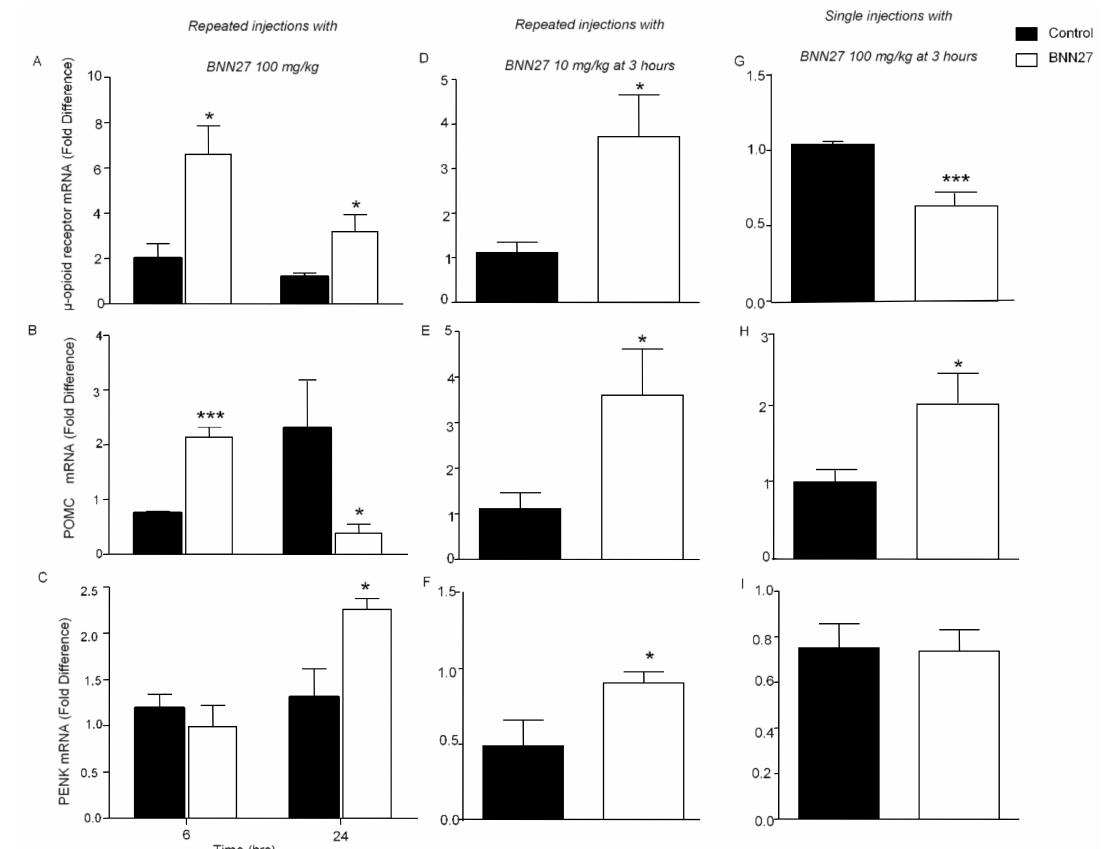
Figure 7. BNN27 induced the expression of opioid peptides and µ -opioid receptor in the inflamed paw. Repeated injections of 100 mg/kg increased the µ -opioid receptor mRNA levels at 6 and 24 h ( A ) as well as POMC mRNA levels at 6 h ( B ) and PENK mRNA levels at 24 h ( C ). Repeated injections of 10 mg/kg increased µ -opioid receptor, POMC and PENK mRNA levels at 3 h ( D – F ). Single treatment at 100 mg/kg decreased the µ -opioid receptor mRNA ( G ) and increased the POMC mRNA levels ( H ). No changes were observed in the PENK mRNA levels ( I ). ( A ) At 6 h, Control n = 3 mice, BNN27-treated group n = 4 mice; at 24 h: Control n = 4 mice, BNN27-treated group n = 4 mice. ( B ) At 6 h, POMC: Control n = 3 mice, BNN27-treated group n = 5 mice; at 24 h: Control n = 5 mice, BNN27-treated group n = 5 mice. ( C ) At 6 h, Control n = 4 mice, BNN27-treated group n = 4 mice; at 24 h: Control group n = 4 mice, BNN27-treated group n = 4 mice. ( D ) Control n = 5 mice, BNN27-treated group n = 5 mice. ( E ) Control n = 5 mice, BNN27-treated group n = 5 mice. ( F ) Control n = 4 mice, BNN27-treated group n = 5 mice. ( G ) Control n = 4 mice, BNN27-treated group n = 5 mice. ( H ) Control n = 4 mice, BNN27-treated group n = 5 mice. ( I ) Control n = 4 mice, BNN27-treated group n = 5 mice. In all panels * p < 0.05, *** p < 0.001. Statistical analysis was performed using unpaired t -tests. All data are expressed as the mean ±